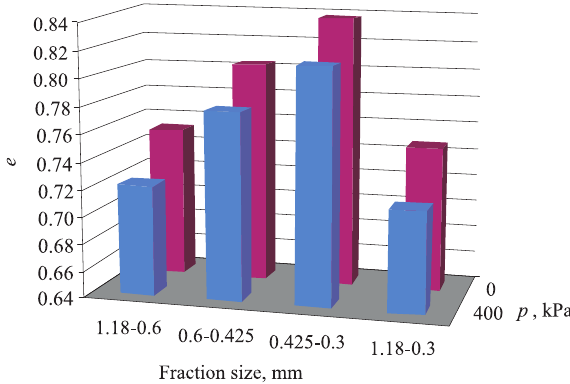
Fig. 7. Summary of experimental porosities: max and min void ratios of separate fractions and fi nal mixture